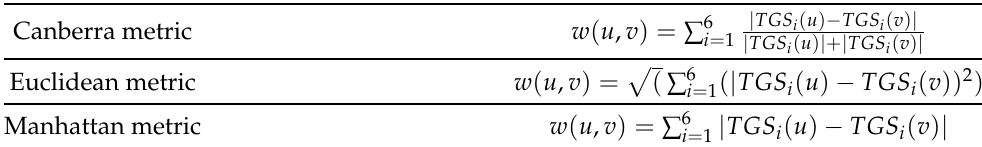
Table 3. Metrics used in the kNN